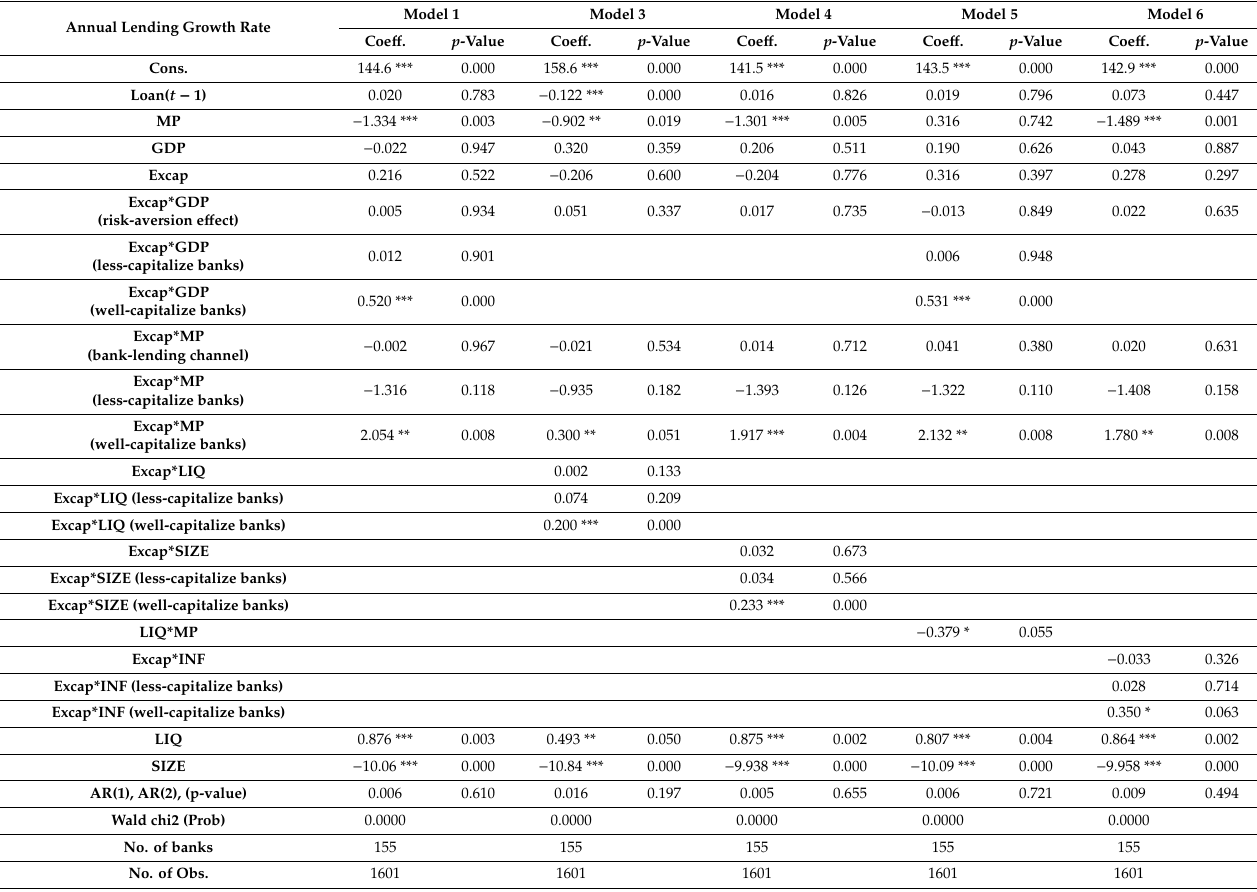
Table 3. Combined Sample